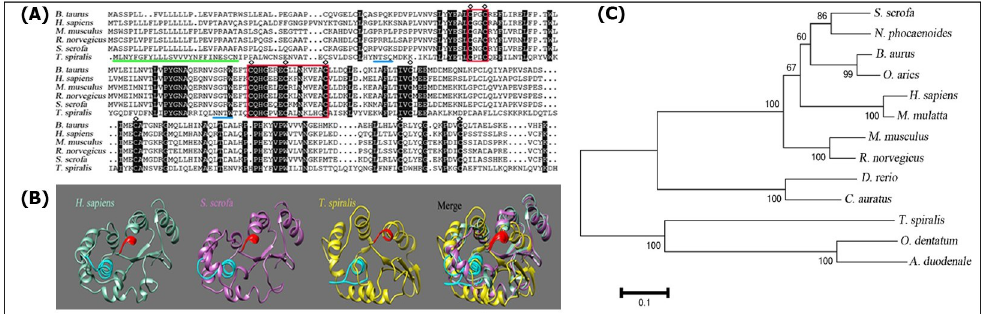
Fig 1. A : Analysis and multi-alignment of rTsp-GILT sequence with GILT of other known species. Identical amino acids among all sequences are indicated by black background. The active-site motif of CXXC and GILT signature sequences are highlighted in red boxes. The predicted signal peptide is marked with green underlining. The glycosylation sites are indicated by blue underlining. The conserved cysteines sites were marked by black � . B : Alignment of the predicted 3D structure of T . spiralis with H . sapiens and S . scrofa . C : The phylogenetic tree of 13 GILT proteins.